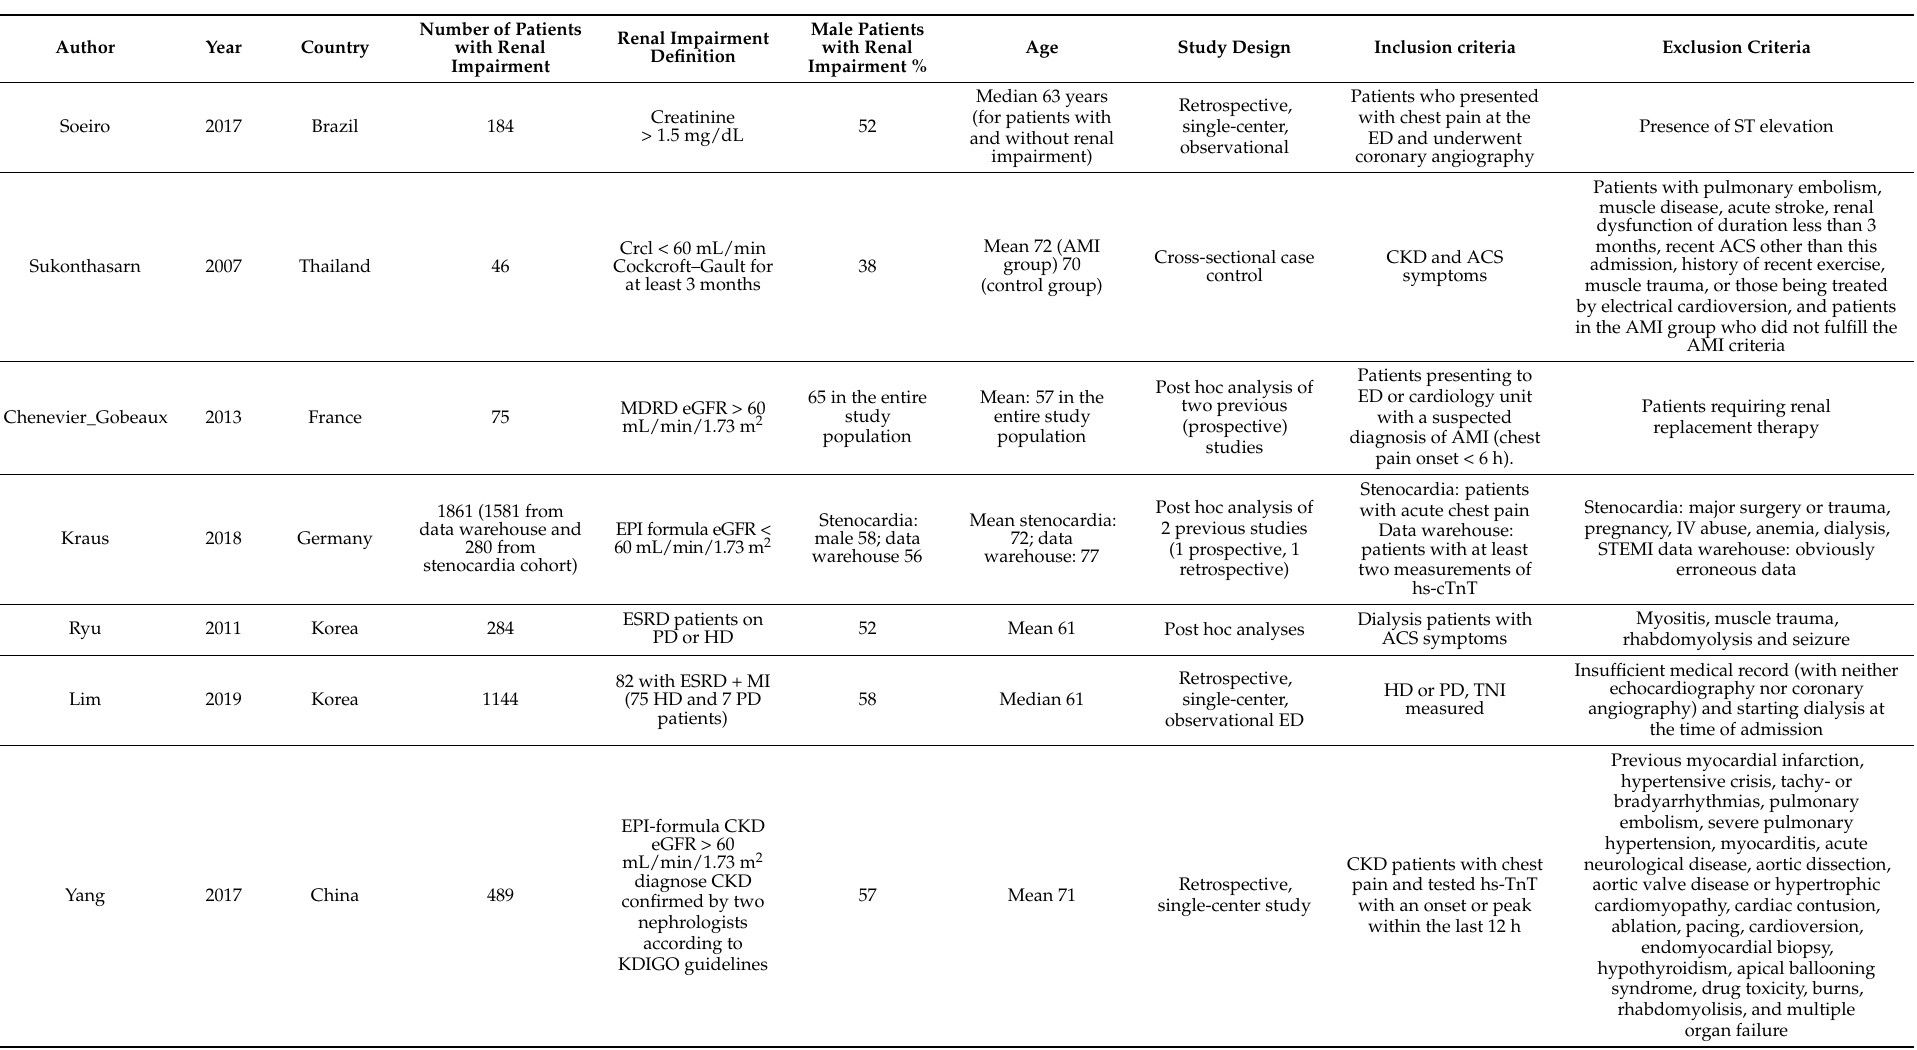
Table 1. Study characteristics of the included studies for the systematic review of cut-off values for troponin in patients with chronic kidney